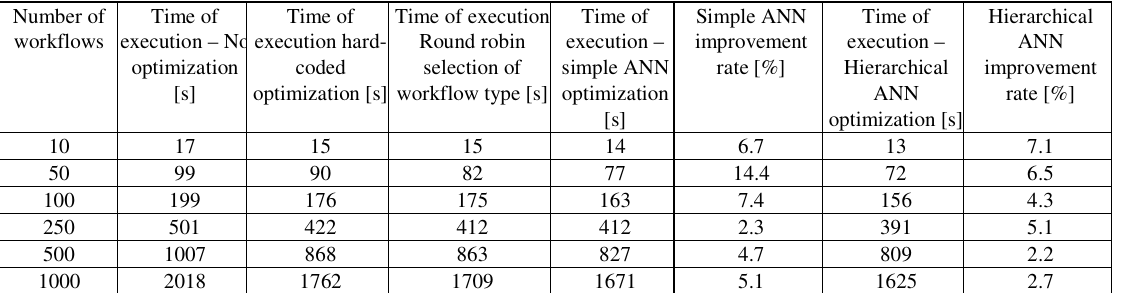
Table 1. Test results for the speed of execution of